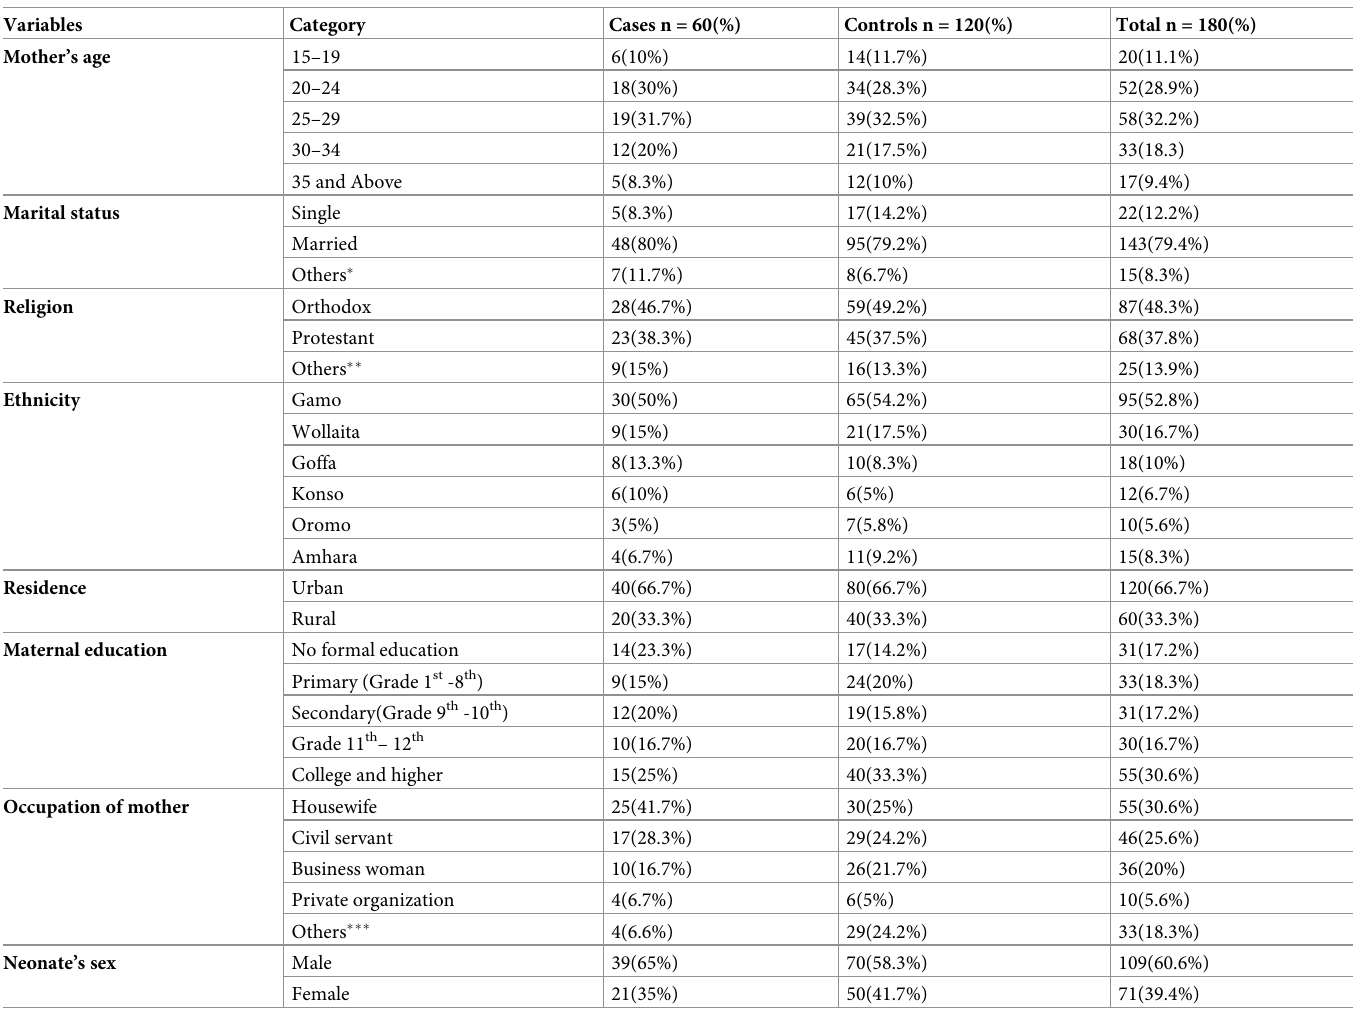
Table 1. Socio-demographic characteristics of the neonates and their mothers included in the